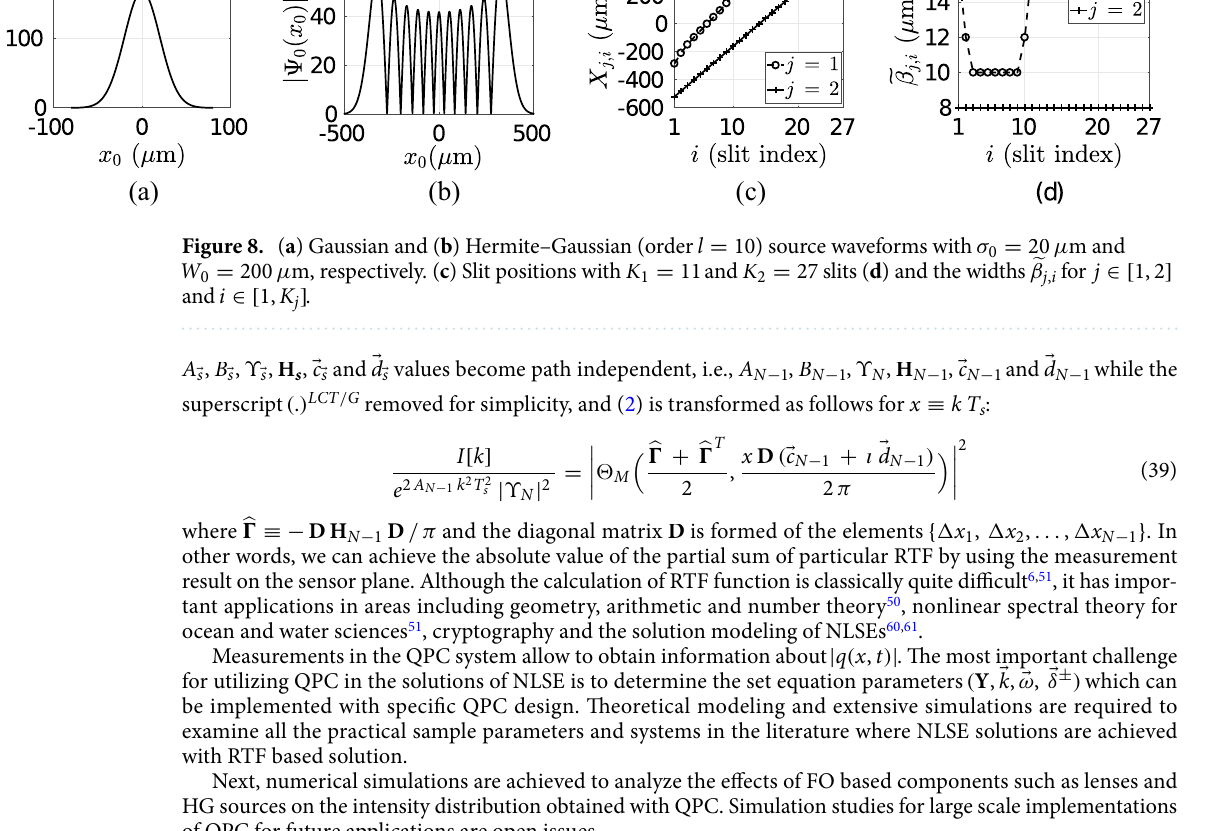
Figure 7. Photonic QPC set-up with Gaussian and HG classical monochromatic light source with (cid:31) two planes for diffraction with the number of slits K 1 LCT and ( b ) FSP design with the only difference of the existence of thin-lenses of focal length of 63 mm in the LCT system.